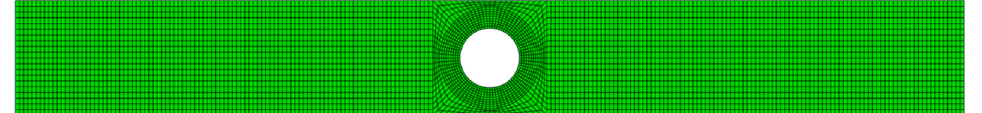
Figure 6. 2D plane stress FE mesh used for stress analysis and finite element model updating (FEMU) inverse characterization using Abaqus FE software.